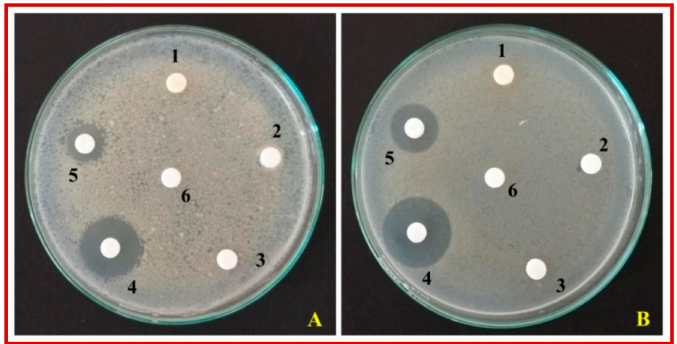
Figure 7. Antibacterial activity of ZnO-NPs green synthesized using C. verum hexane extract. ( A ): E. coli ; ( B ): S. aureus ; 1: C. verum hexane extract; 2: Hexane; 3: Hexane + zinc nitrate hexahydrate; 4: Streptomycin; 5: ZnO-NPs; 6: Sterile distilled water. Table 2. Antibacterial activity of ZnO-NPs green synthesized using C. verum hexane extract. Test